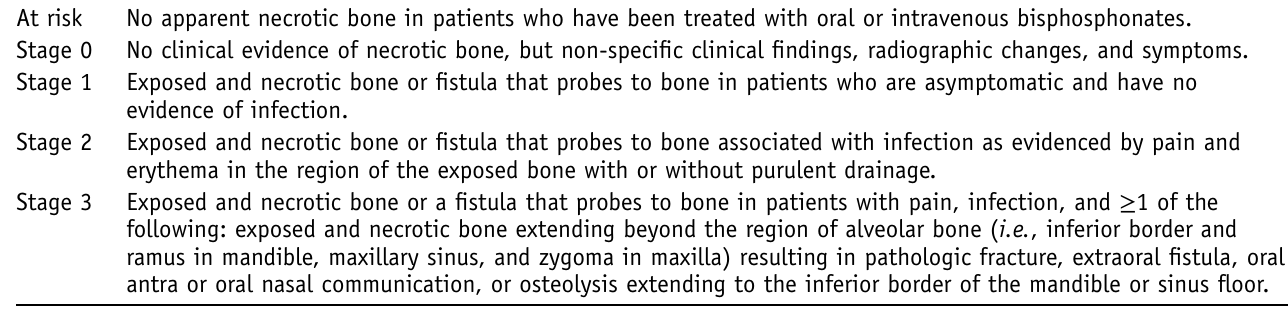
Table I. Staging proposed by the American Association of Oral and Maxillofacial Surgeons (AAOMS). At